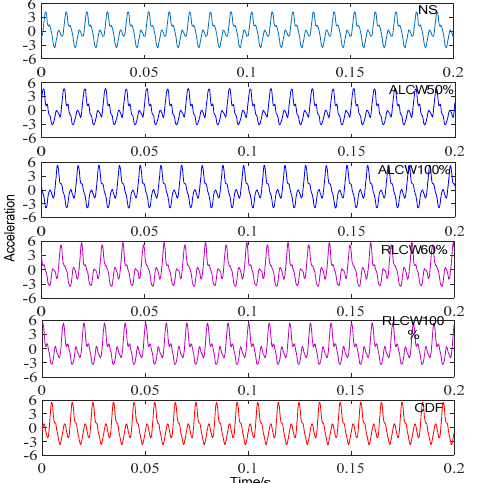
Figure 8. Time domain waveform of the vibration signal at measuring point No. 42.